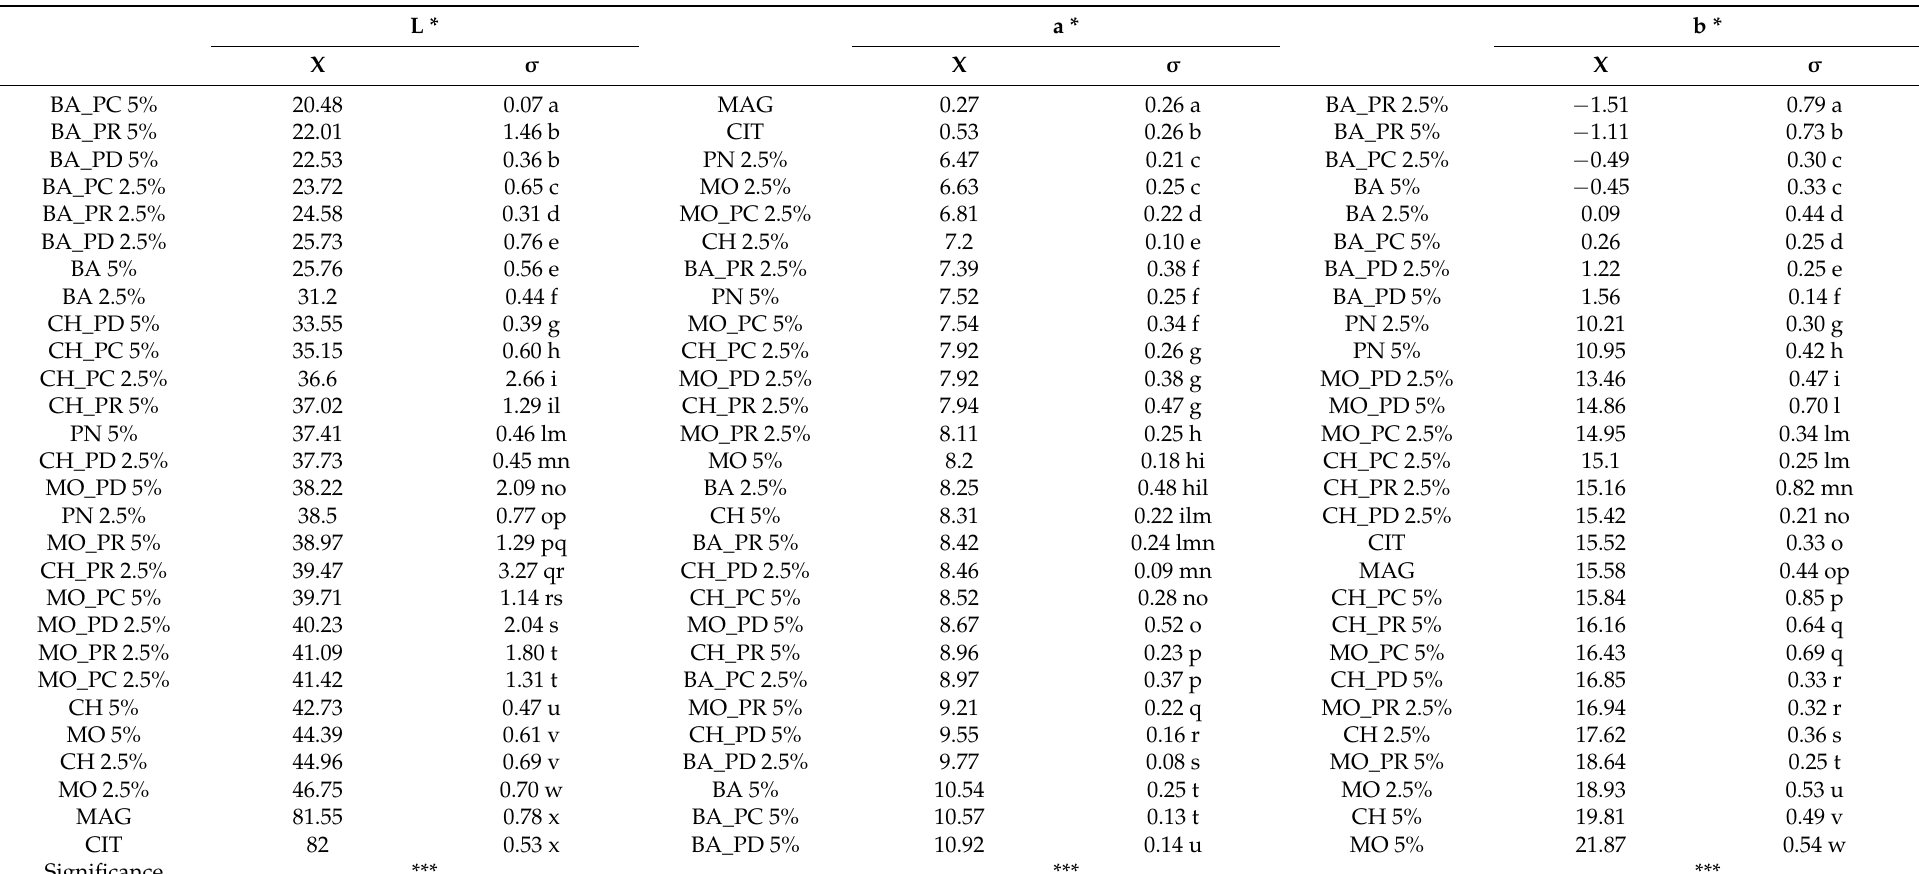
Table 2. Values (X—mean; σ —standard deviation) of CIELab parameters (L*, a*, b*) of the tofu samples obtained with the traditional and innovative coagulants at two concentrations (2.5% and 5%) and results of the variance analysis with post hoc Duncan’s test calculated among all samples (BA—Barbera; CH—Chardonnay; PN—Pinot Noir; MO—Moscato; MAG—magnesium chloride; CIT—citric acid; PR—pre-distillation; PC—post-distillation continuous; PD—post-distillation